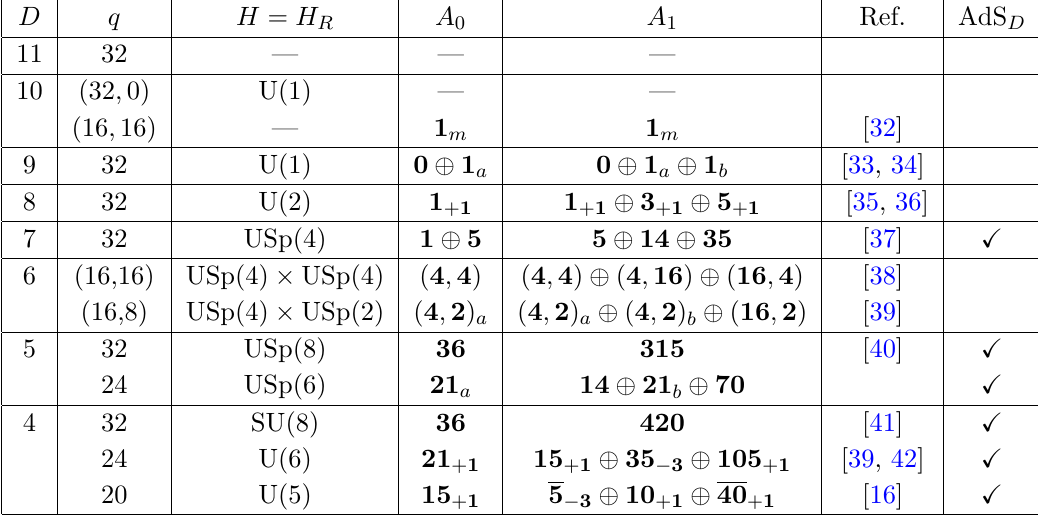
Table 1 . Deformations of supergravities with q > 16 and D (cid:21) 4. The last column indicates whether a maximally supersymmetric AdS solution is possible. A subscript \ m " denotes a massive deforma- tion. If there are multiple independent deformations transforming in the same H R representation they are distinguished by the subscripts \ a " and \ b ". 1 m denotes the massive deformation of type IIA supergravity. Integer subscripts denote the respective U(1)